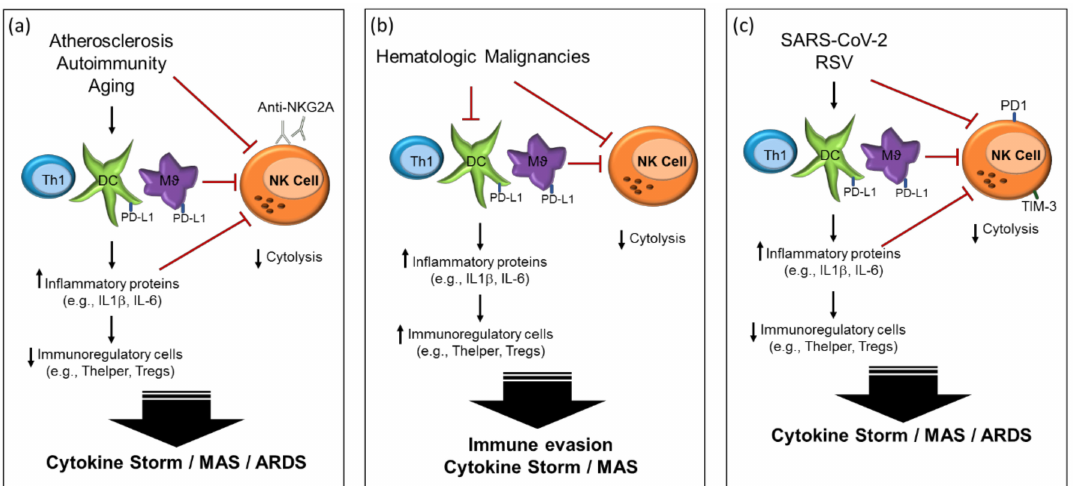
Figure 2. Natural killer cell dysregulation in ( a ) systemic diseases; ( b ) hematologic malignancies; ( c ) SARS-CoV-2. ( a ) Immune imbalance in atherosclerosis, autoimmunity and ageing leads to excess inflammation; ( b ) Hematologic malignancies trigger both excess inflammation and immune invasion; ( c ) SARS-CoV-2 and respiratory syncytial virus (RSV) trigger immune imbalances which result in a disproportionate inflammatory